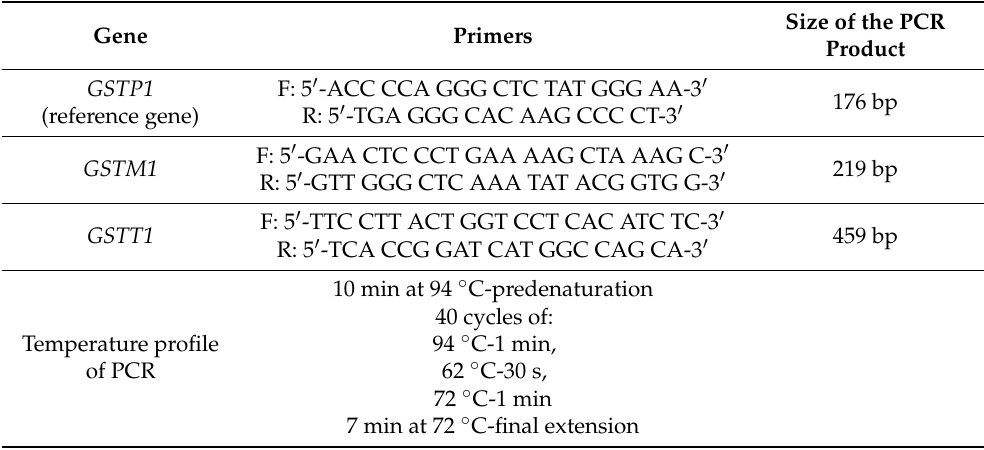
Table 2. Primer sequences, size of the PCR products, and temperature profile used in the multiplex (duplex) PCR for genotyping for null GSTM1 and GSTT1